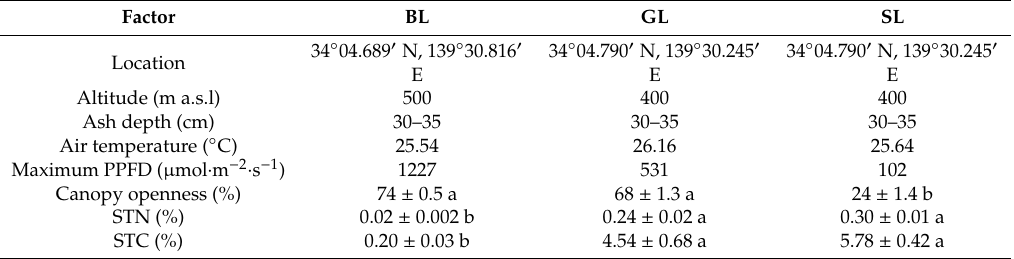
Table 1. Location and morphometric characteristics of bare land (BL), shrub land gap (SLG) and shrub land under canopy (SLUC). Di ff erent letters indicate significant di ff erences between the study sites revealed by Steel Dwass post hoc test at a significance level p < 0.05 after Kruskal–Wallis test. Abbreviations are meters above sea level (m a.s.l); photosynthetic photon flux density (PPFD); soil total N (STN) (n = 30); soil total carbon (STC) (n = 30); Canopy openness (n = 48).